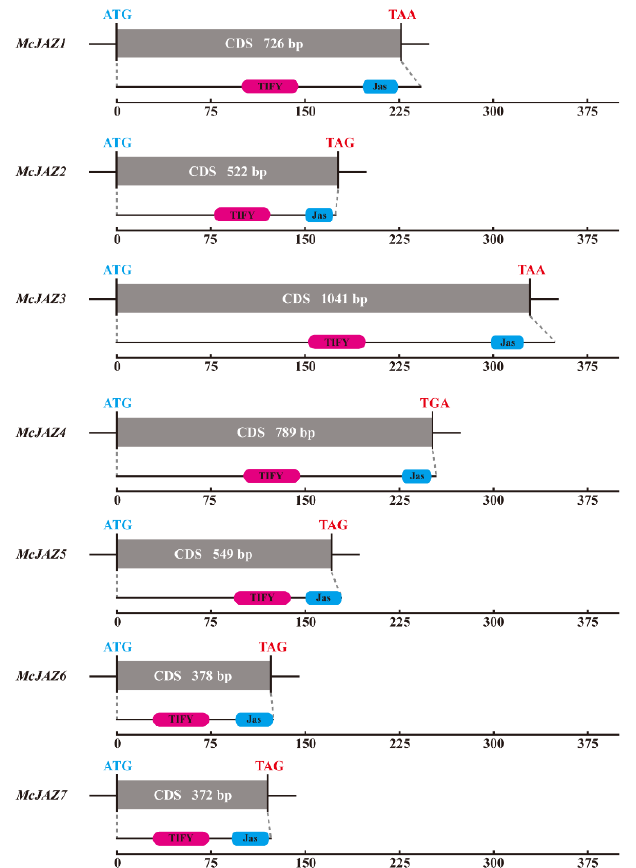
Figure 1. McJAZ genes and domain architectures of McJAZ proteins in M. canadensis . Shown above are the coding sequences (CDs) of the seven focal McJAZ genes, and the domain architectures of these McJAZ proteins. The McJAZ proteins share a conserved TIFY domain (indicated by a pink box), and Jas domain (indicated by a blue box) with other JAZ homologous proteins in other plant species. Table 1. Molecular characteristics of McJAZ genes in M. canadensis.